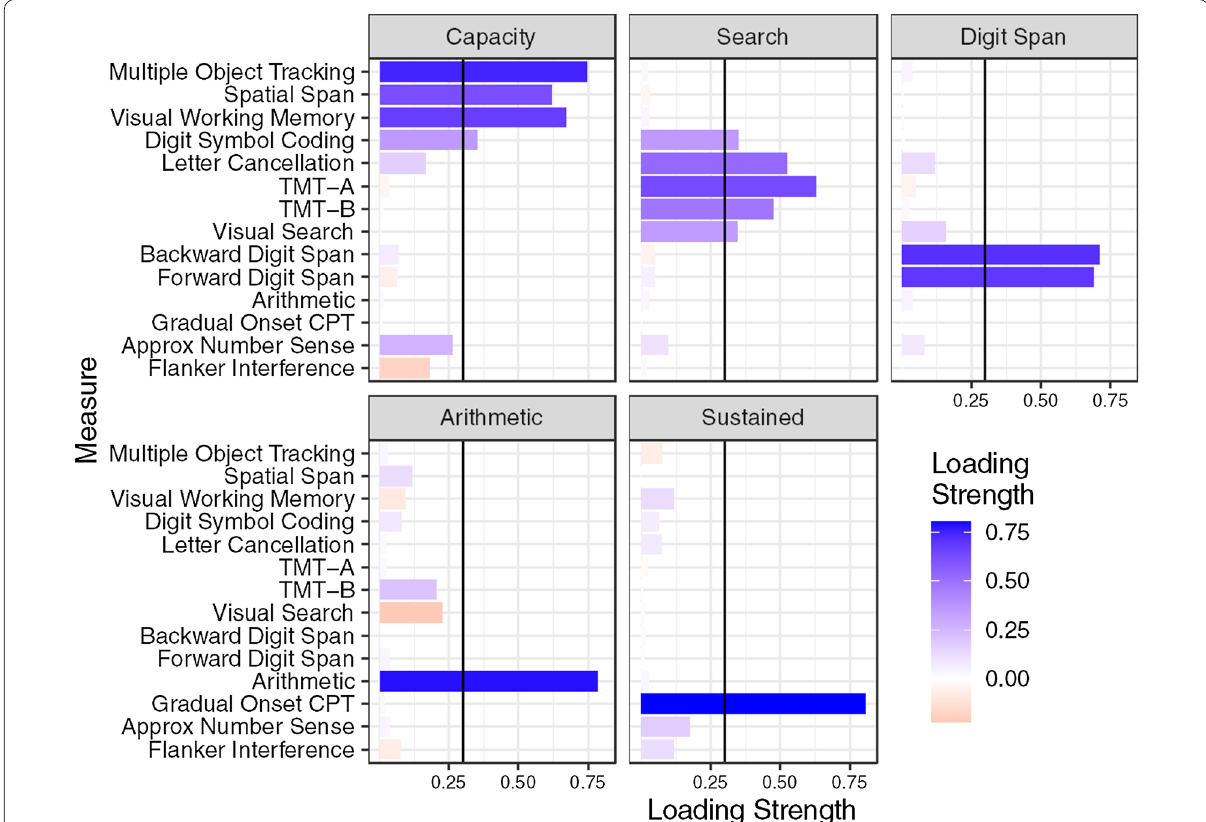
Fig. 4 Factor loadings from the five-factor exploratory factor analysis. Blue indicates positive loadings, red negative. The vertical line on each panel denotes the .30 threshold for inclusion of a measure in a given